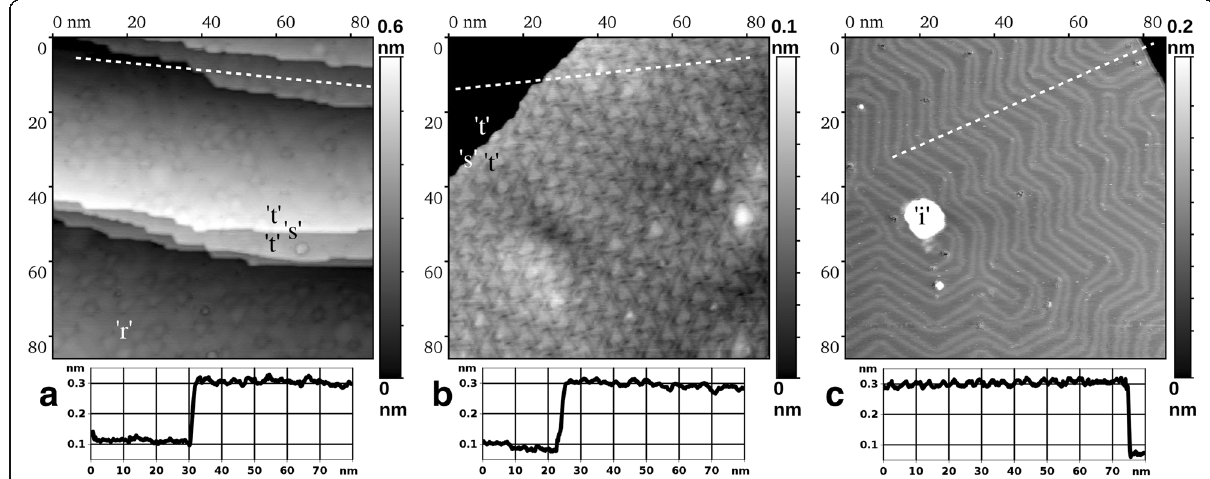
Fig. 2 STM images (86 nm×86 nm) of atomically flat Au(111) surfaces. a, b Thin Au films grown on Ru(0001) at RT and annealed at 1050 K during 5 min; a nominal coverage 5 ML, sample bias voltage: U = − 0.2 V, tunneling current: I =3 nA, b 9 ML, U = − 0.003 V, I =10 nA, c single-crystal Au(111) sample; U = − 0.003 V, I =10 nA. Please note the different gray scales given to the right of every image. The height-distance cross-sections along the white dashed lines are presented below every image. Designations: “ t ” — atomically flat terraces, “ s ” — single atomic steps, “ r ” — ripples, “ i ” — impurity cluster